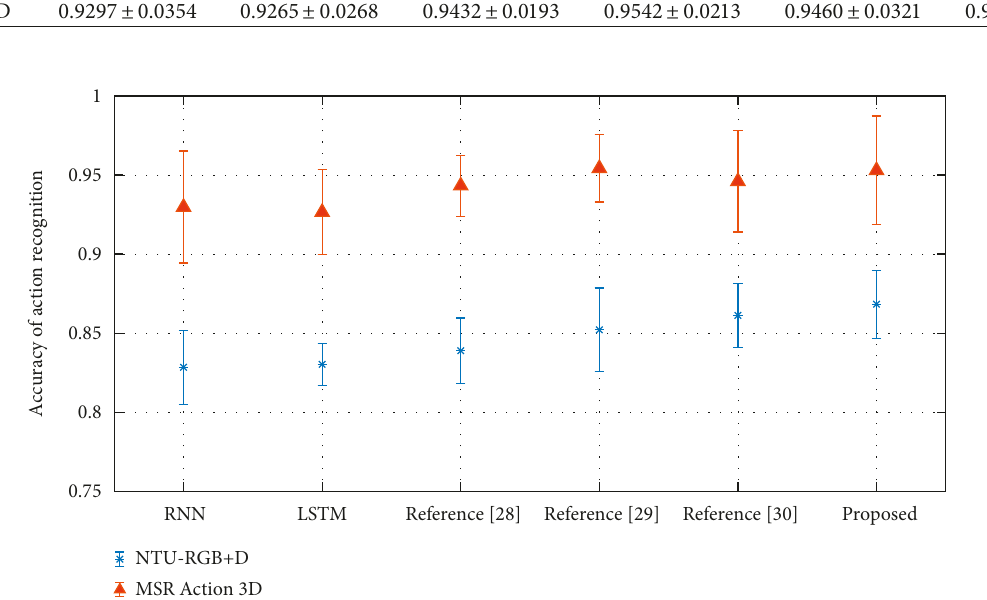
Figure 9: Comparison of the accuracy of action recognition obtained by different